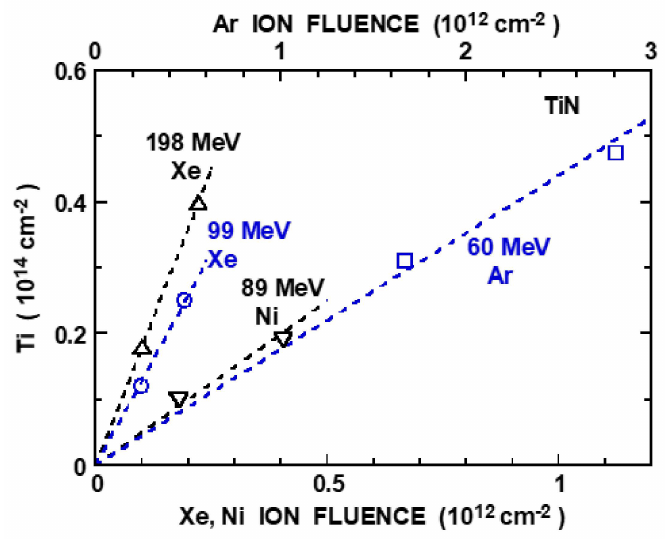
Figure 9. Areal density of sputtered Ti from TiN on SiO 2 substrate collected in carbon foil vs. ion fluence for 60 MeV Ar ( (cid:3) ), 89 MeV Ni ( ∇ ), 99 MeV Xe (o) and 198 MeV Xe ( ∆ ) ions. An estimated error of areal density is 20%.